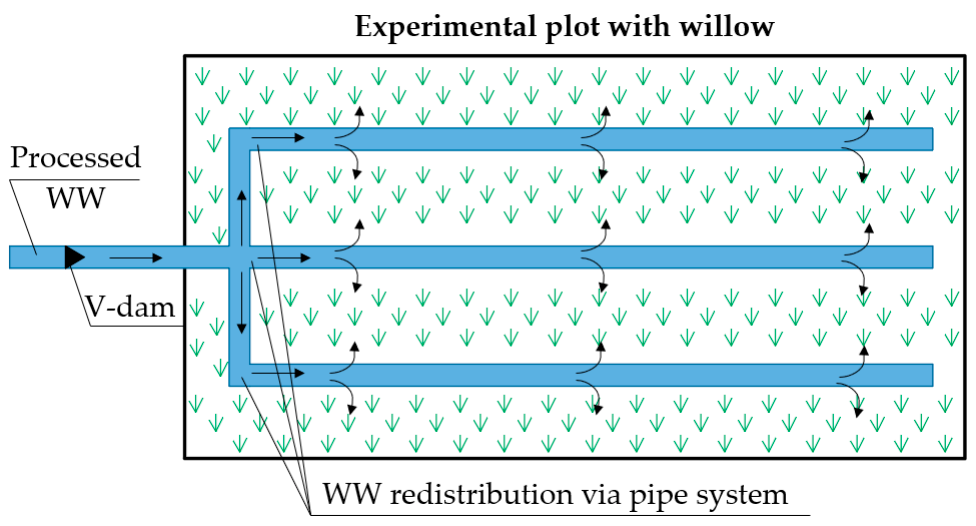
Figure 2. The scheme of irrigation system in Jokipohja Outokumpu experiment plot with willow.